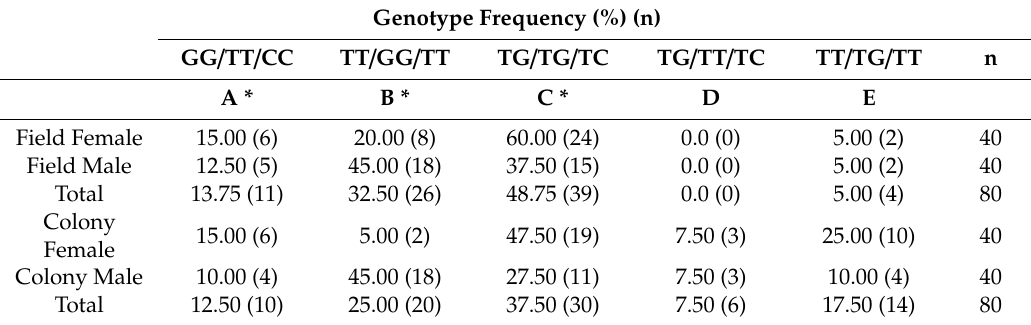
Table 4. Comparison of Vssc genotypes found in field (Shah Alam, 2016) and colony (B3F3 IMR) samples of Aedes aegypti (order of mutation sites 1016 / 1534 / 989) at the time of initial Wolbachia releases.